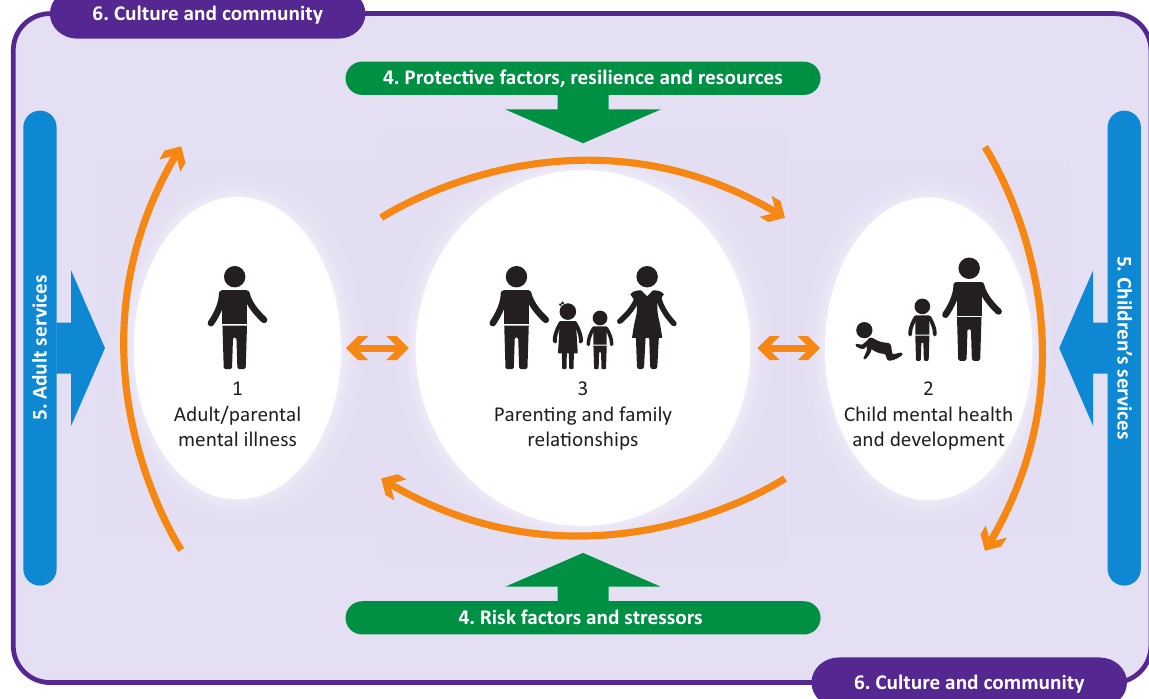
Figure 1. Cross-sectional components of TFM (Falkov,